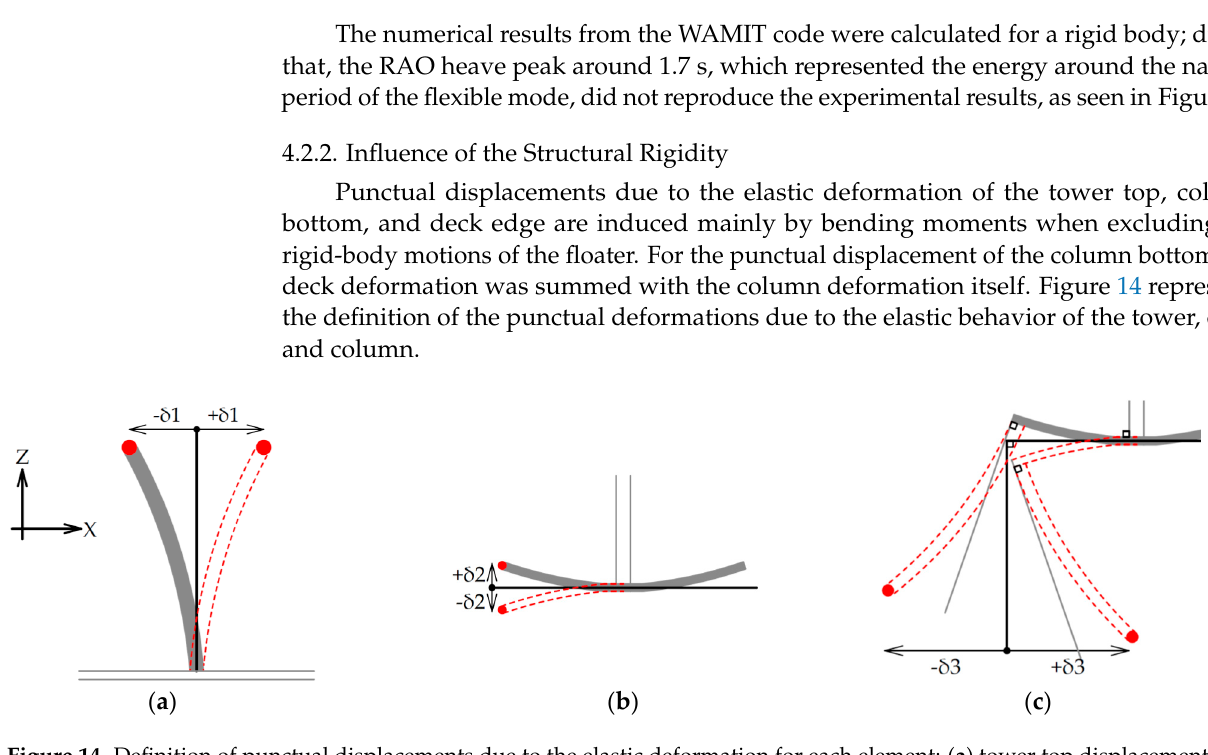
Figure 14. Definition of punctual displacements due to the elastic deformation for each element: ( a ) tower top displacement due to the elastic deformation ( δ 1); ( b ) deck edge elastic displacement due to the elastic deformation ( δ 2); ( c) column bottom displacement due to the elastic deformation displacement ( δ 3).